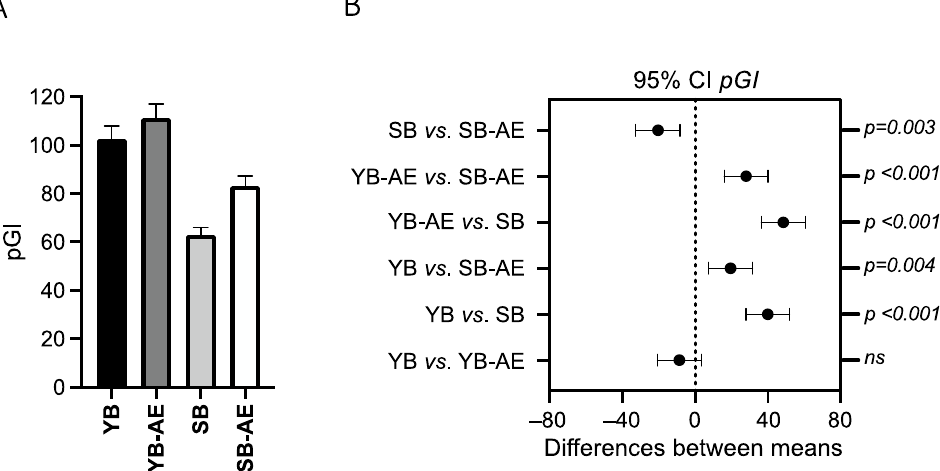
Figure 1. The predicted glycemic index ( pGI ) stacked bars ( A ) of digested bread samples prepared with or without type-II sourdough (S and Y, respectively) and with or without a powdered artichoke extract (AE). Statistical comparison ( B ) shows the 95% confidence interval (CI) and related p -values ( p ). ns: not signi fi cant.